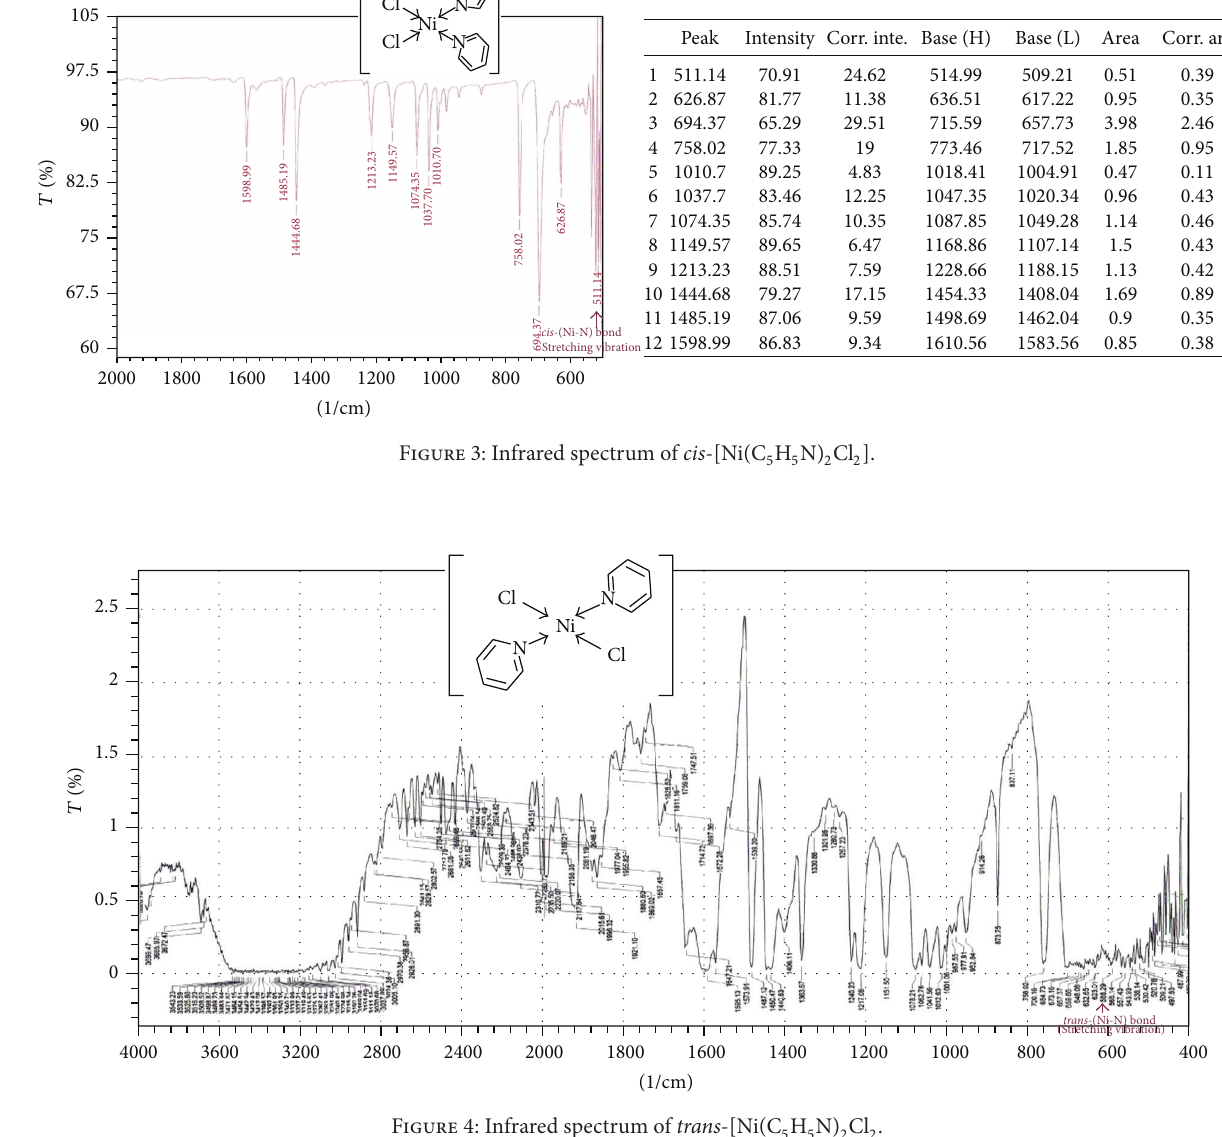
Figure 4: Infrared spectrum of trans -[Ni(C 5 H 5 N) 2 Cl 2 .